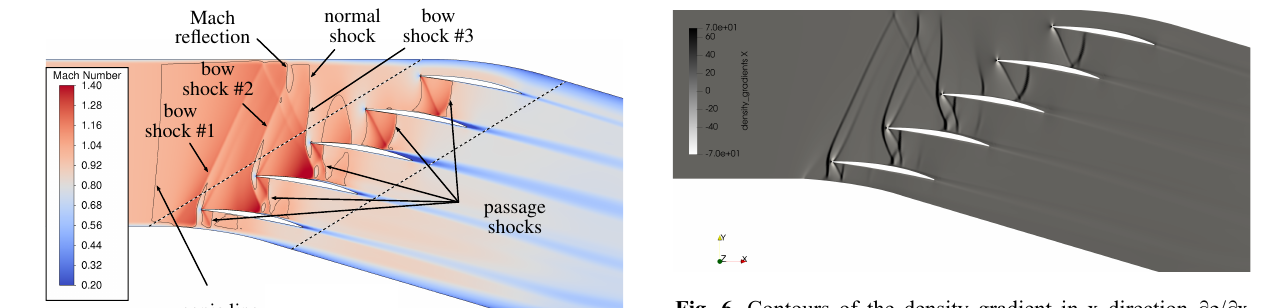
Fig. 6. Contours of the density gradient in x direction ∂ρ/∂x depicting shock waves in the flow field around the cascade.